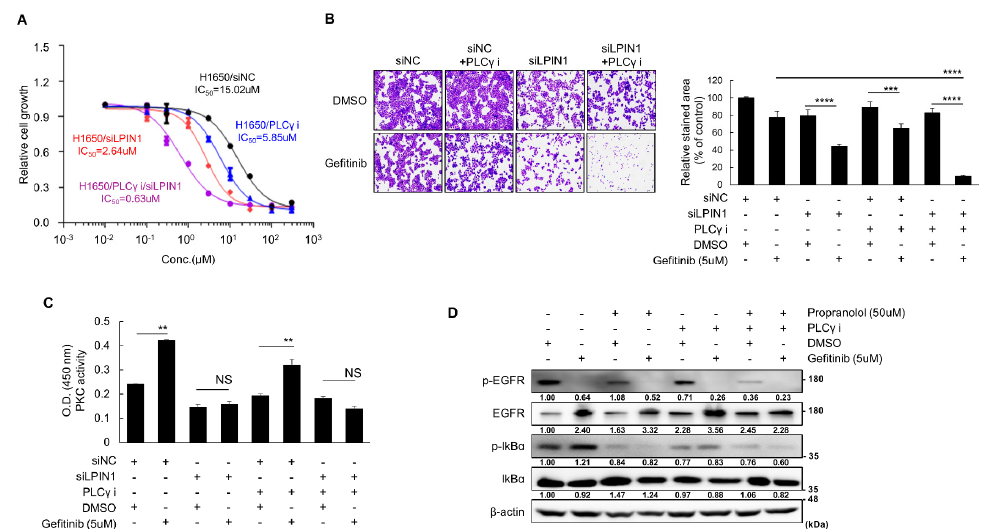
Figure 4. Gefitinib resistance is highly dependent on the total amount of DAG in H1650 cells. ( A ) H1650 cells were transfected with siRNAs for LPIN1 and treated with a PLC γ inhibitor (5 µ M) or a vehicle in combination with varying gefitinib concentrations. The gefitinib sensitivity of each cell line was determined using varying gefitinib concentrations. ( B ) H1650 cells were transfected with siRNAs for LPIN1 and treated with the PLC γ inhibitor (5 μ M) or vehicle in combination with gefitinib (5 µ M) or DMSO for 96 h; cell growth was measured using 0.5% crystal violet staining. ( C ) H1650 cells were transfected with siRNAs for LPIN1, treated with PLC γ inhibitor (5 μ M) or vehicle in combination with gefitinib (5 μ M) or DMSO for 72 h, and harvested to detect their PKC activity. ( D ) H1650 cells were treated with propranolol (50 μ M), PLC γ inhibitor (5 μ M) or vehicle in combi- nation with gefitinib (5 μ M) or DMSO for 24 h and harvested to determine p-I κ B α expression levels. Values are the mean ± SD of three independent experiments. Statistical significance was determined by ( B ) two-way ANOVA or ( C ) Student’s t -test (**, p < 0.01; ***, p < 0.001; ****, p < 0.0001; and NS, not significant).